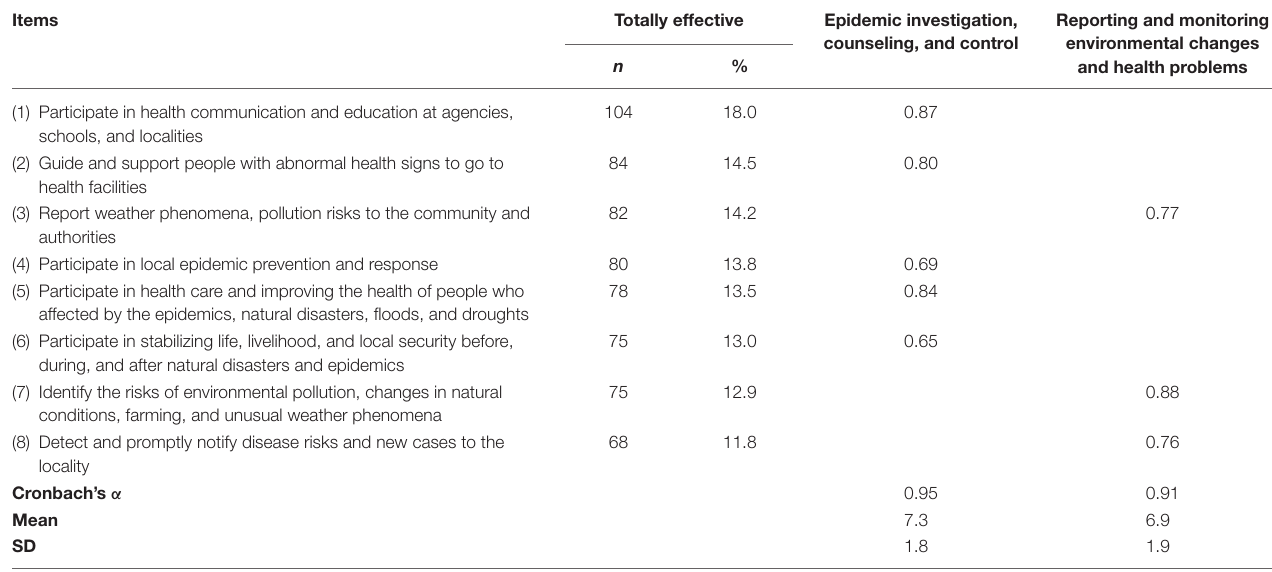
TABLE 3 | Factor loadings of the questionnaire measuring the perceived efficiency of involving community service workers in health care–related activities at grassroots levels. Items